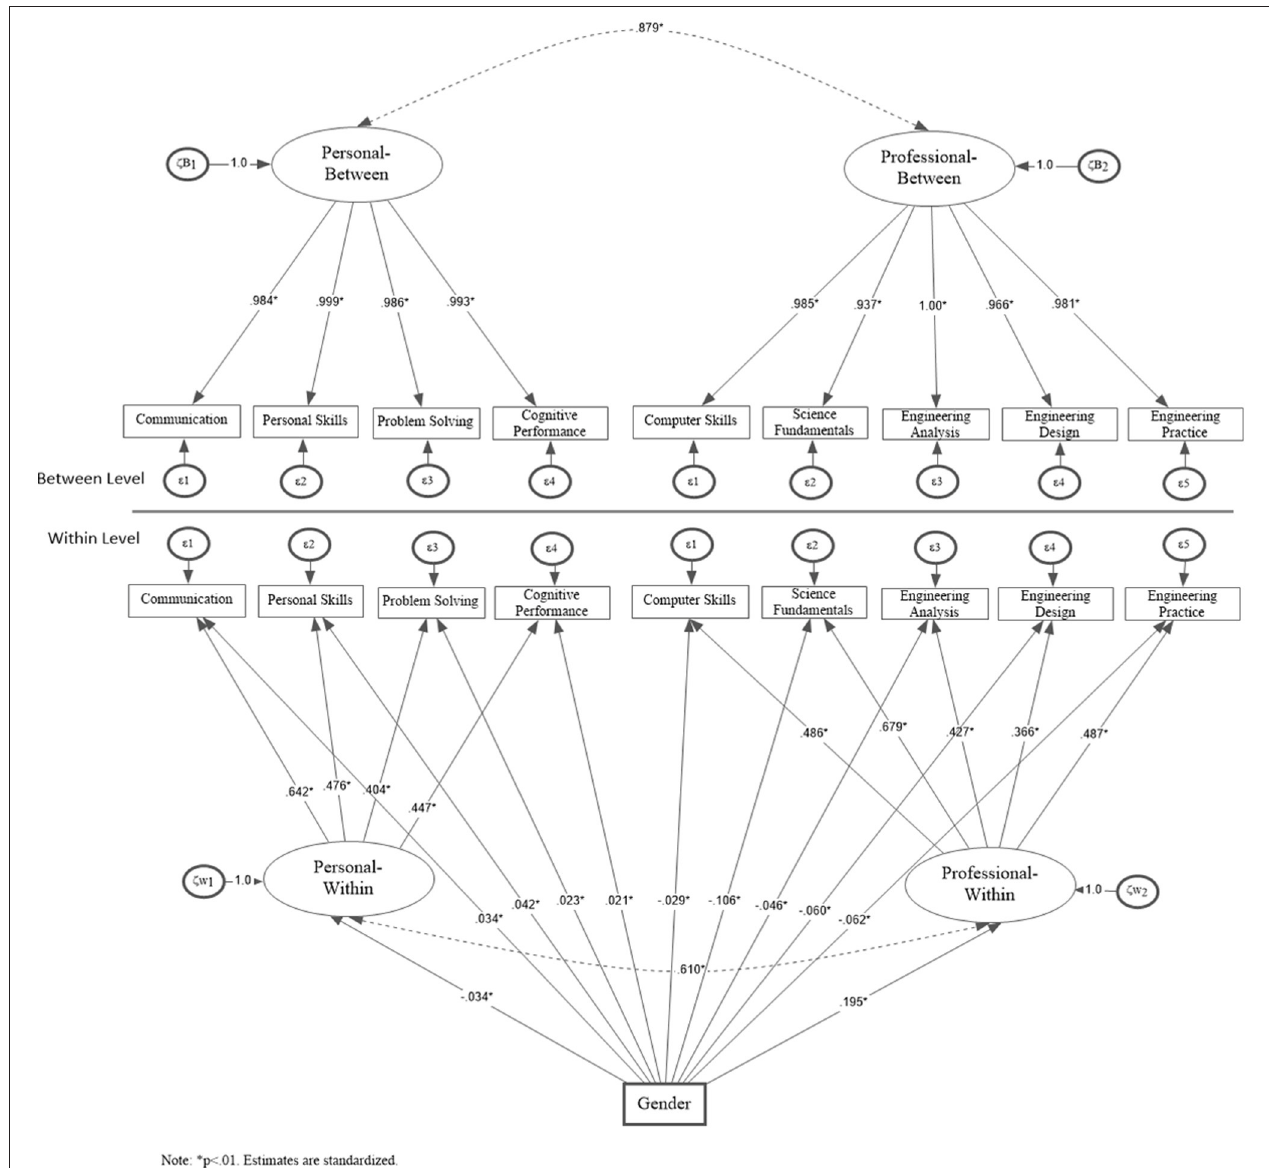
FIGURE 3 | Multilevel MIMIC model for testing invariance across gender at the within part of the model (N w =